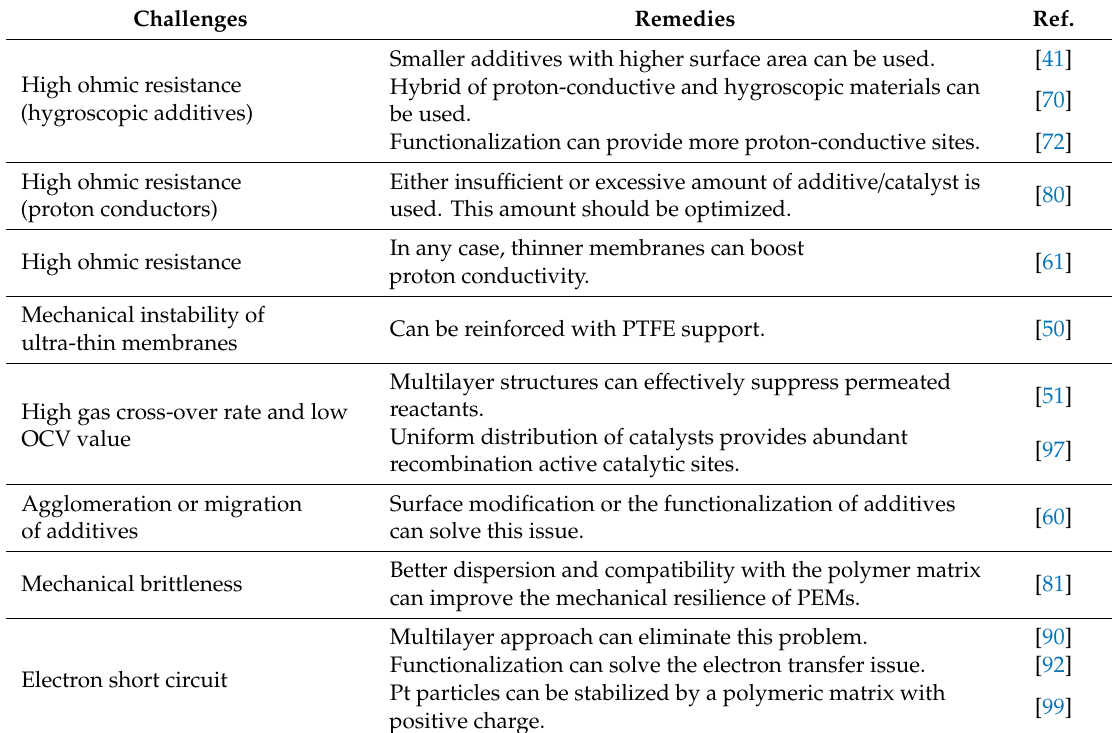
Table 2. Challenges and presented remedies in the field of self-humidifying